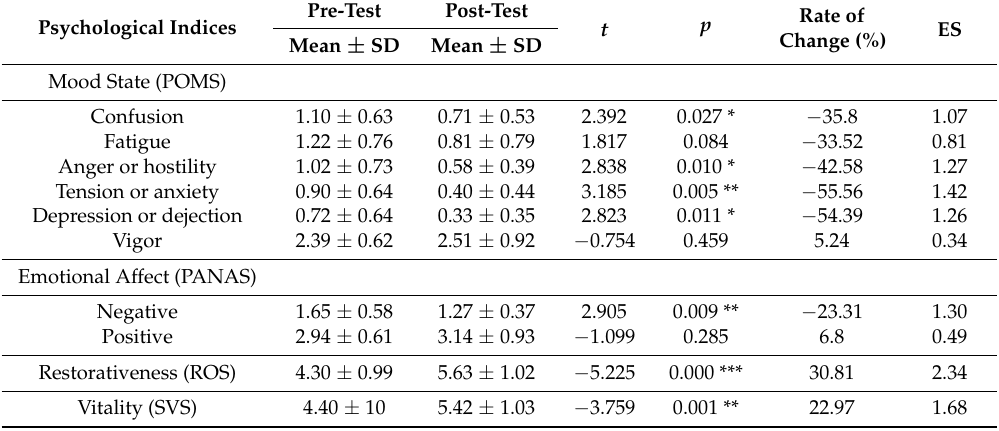
Table 4. Effects of the forest recreation program on emotional state, emotional affect, restoration, and vitality.